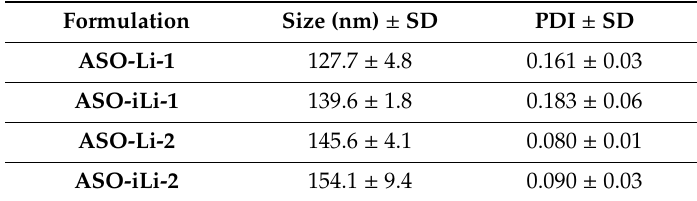
Table 1. Size and polydispersity index (PDI) comparison for both formulations of liposomes and immunoliposomes.